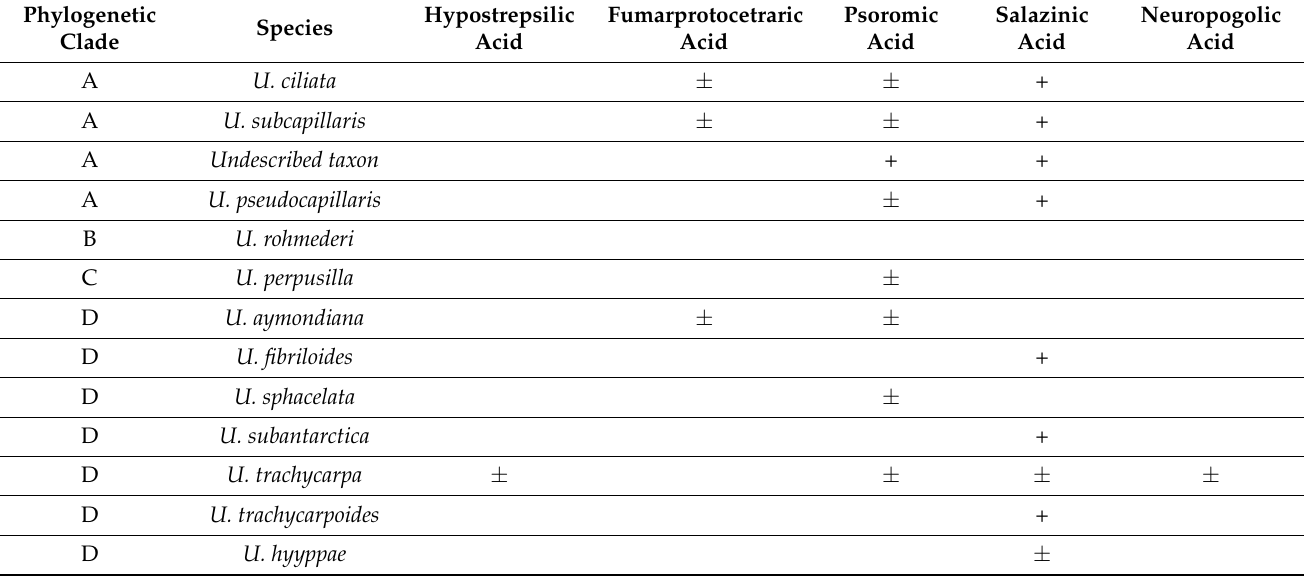
Table 1. Chemosyndromes identified following [65] for each species of the four clades of taxonomical interest (Clades A–D; Figure 1). + indicates chemosyndrome constantly or frequently present in high concentration, ± indicates chemosyndrome either sometimes present in high concentrations or present in low